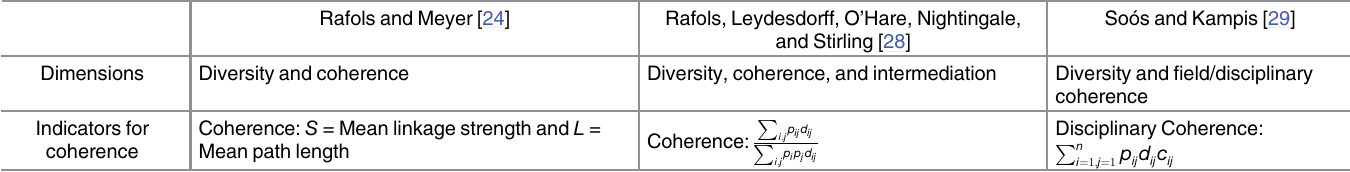
Table 2. Comparison among Studies Concerning Coherence